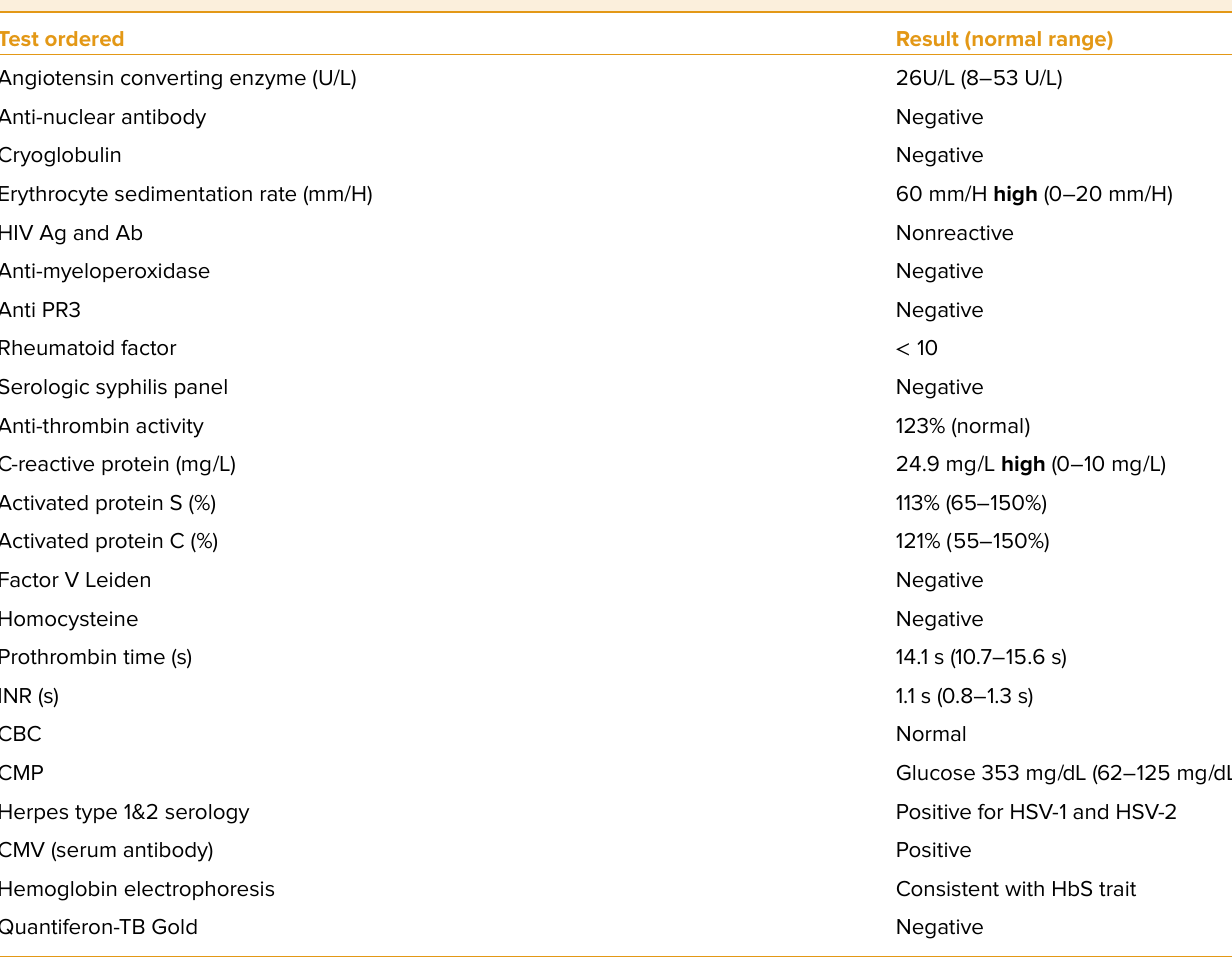
Table 1. Laboratory assessment of other etiologies for extensive peripheral non-perfusion including pro-thrombotic and vasculitic causes Test ordered Angiotensin converting enzyme